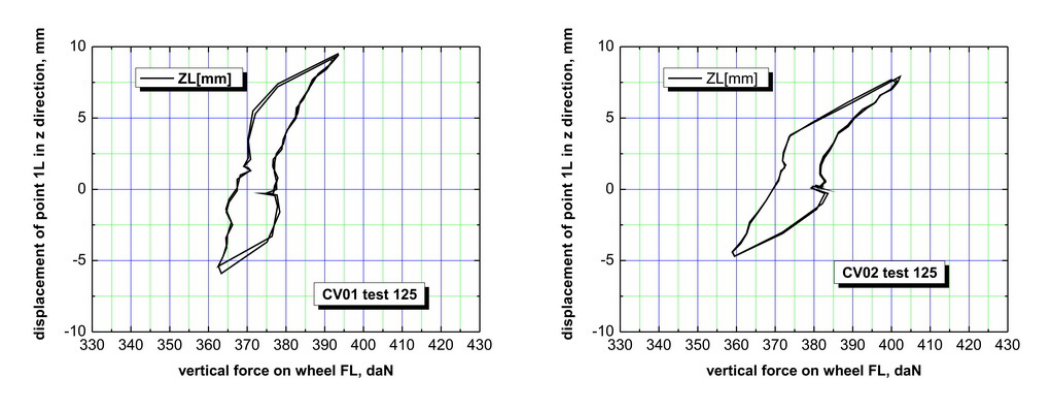
Fig. 5.6. Displacement alterations depending on vertical force during test No.